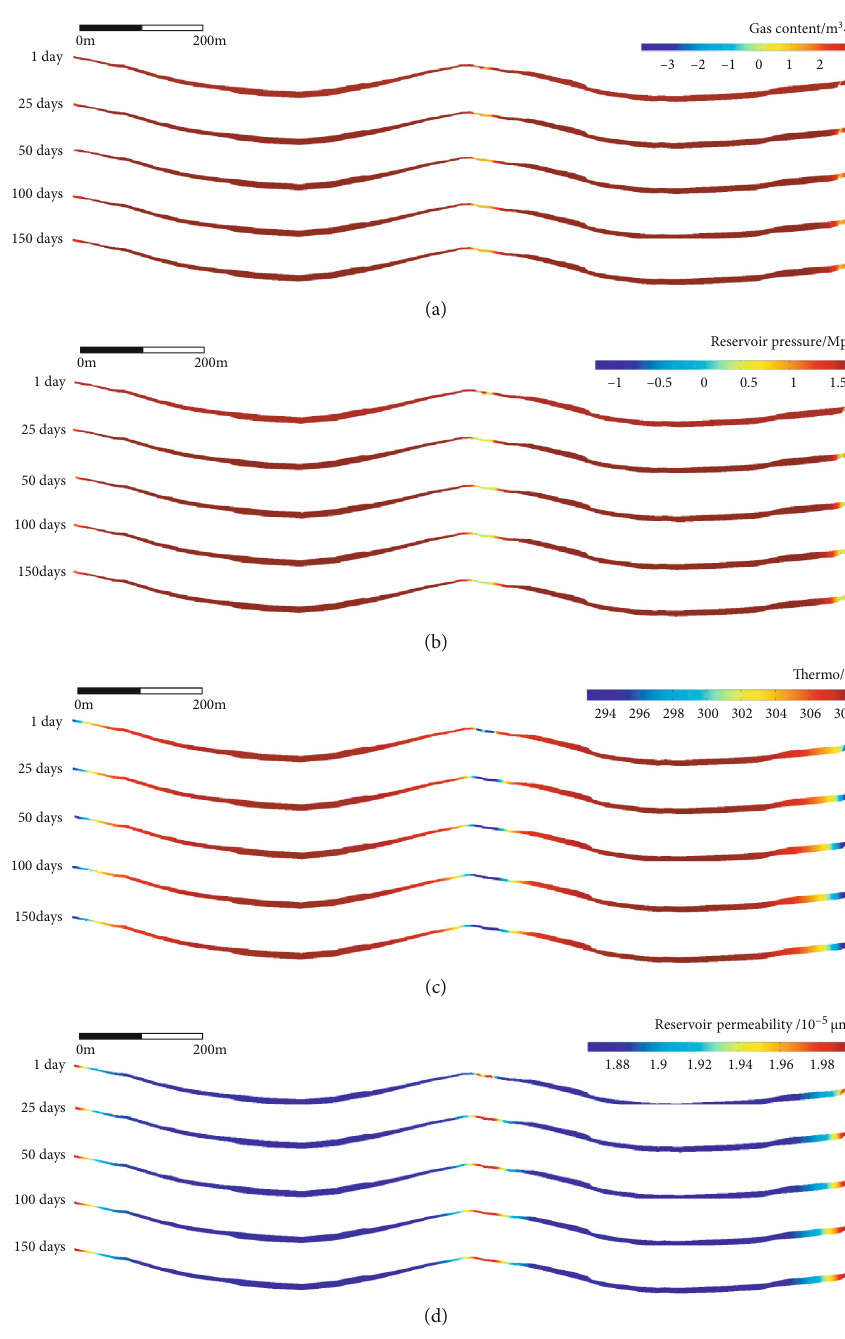
Figure 5: Variation of multiphysical fi elds in di ff erent tectonic positions: (a) CBM content; (b) coal reservoir pressure; (c) coal reservoir temperature; (d) coal reservoir